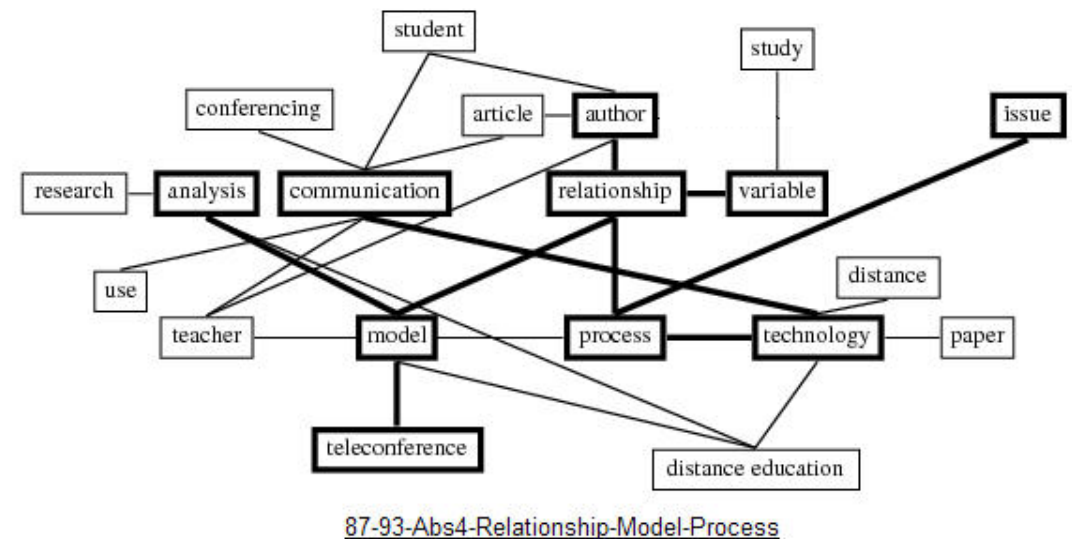
Figure 1 . 87-93-Abs4-Relationship-Model-Process lexical map. Interaction: An emerging and evolving theme in distance